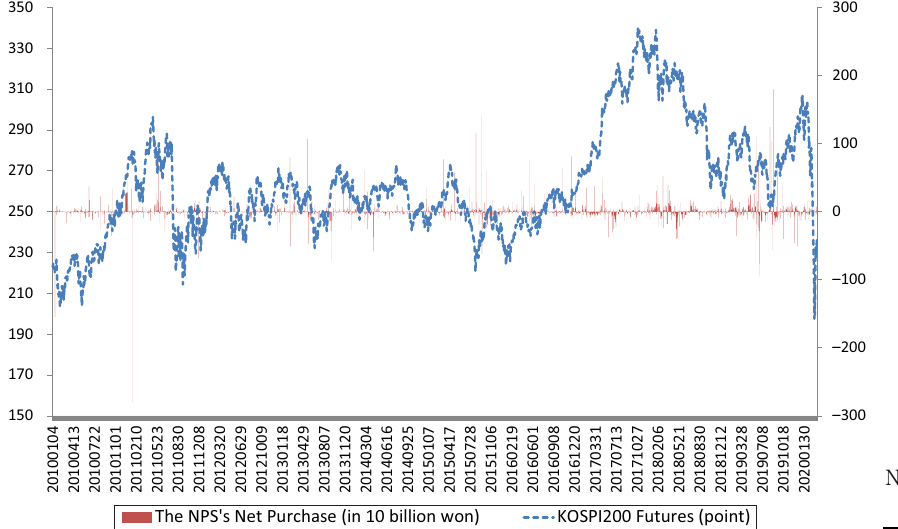
Figure 1. NPS ’ s net purchase